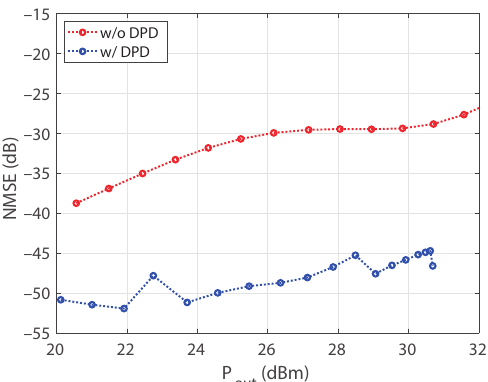
Figure 9. NMSE versus the output power level, without and with the DPD, with a model structure identified at P o = 27.6 dBm and then reused for all the power levels.